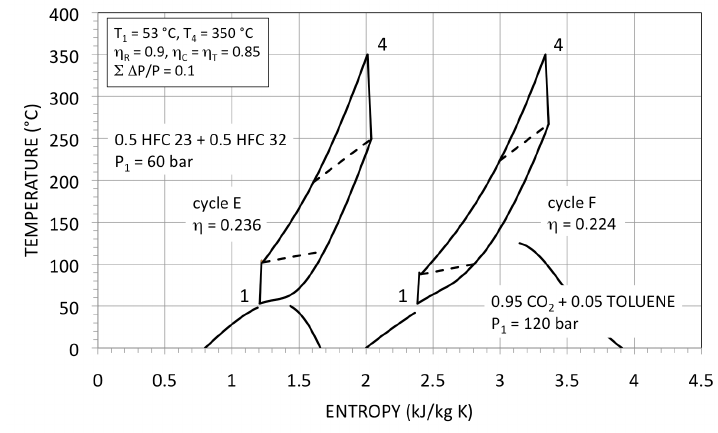
Figure 15. Two real-gas cycles with mixtures as working fluid in the thermodynamic plane